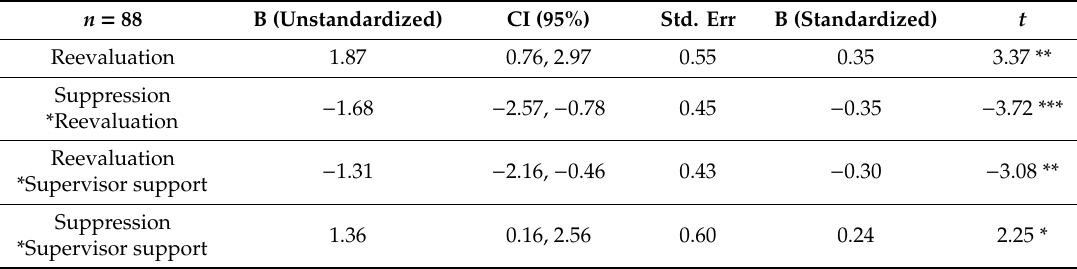
Table 6. Linear regression results for the personal accomplishment